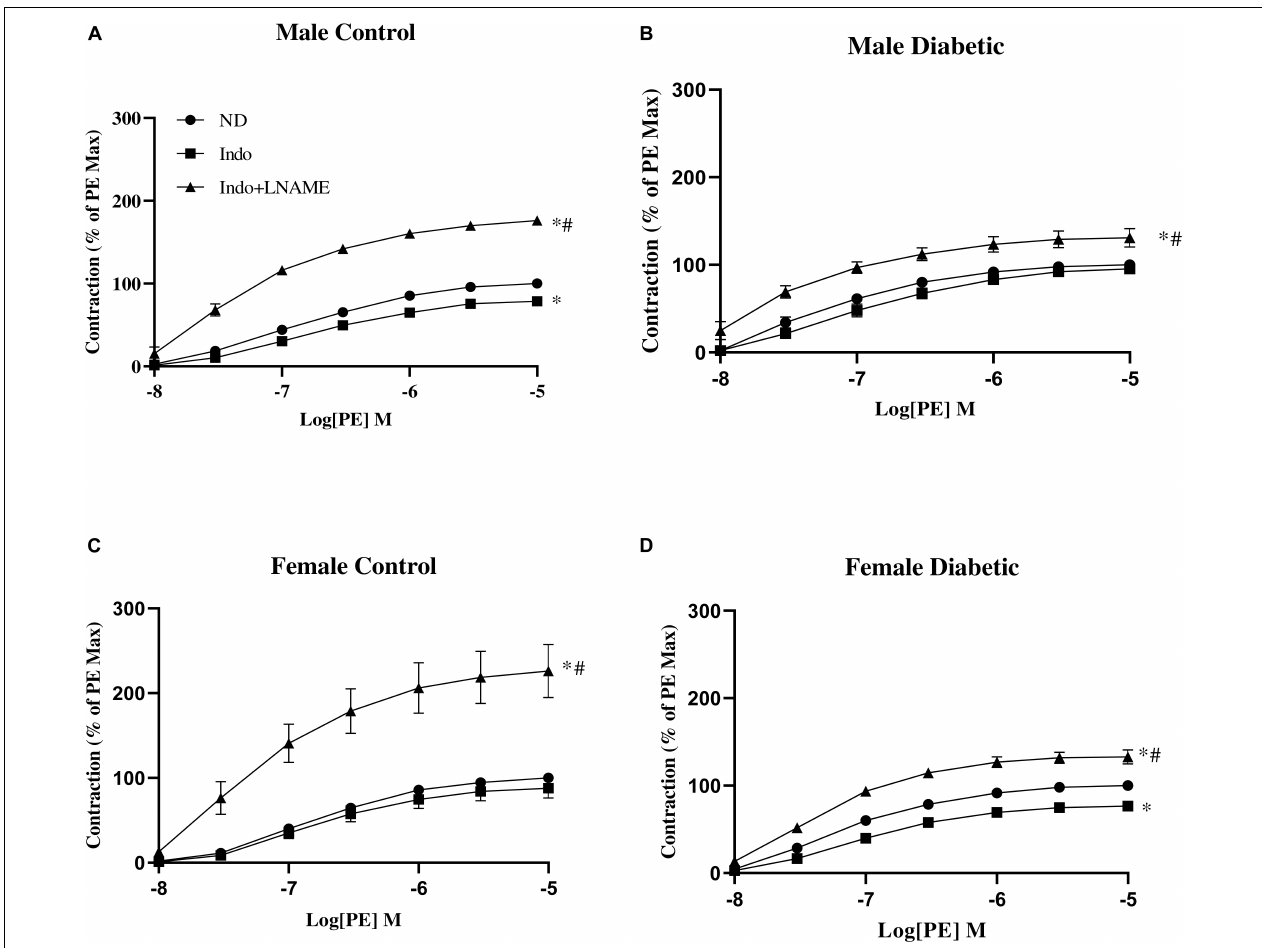
FIGURE 6 | Concentration-response curves to phenylephrine (PE) in intact aortic rings from (A) male control, (B) male diabetic, (C) female control, and (D) female diabetic rats. Contraction to PE was measured in absence of any drug (ND) or in presence of indomethacin (Indo, 10 µ M) followed by addition of N -Nitro-L-arginine methyl ester (Indo + L-NAME, 200 µ M). Results are expressed as a percent of the maximal response to PE (10 µ M) obtained in the absence of any drug. Data are expressed as mean ± SEM, analyzed using two-way ANOVA with repeated measures followed by Tukey’s post hoc test: ∗ p < 0.05 vs. ND; # p < 0.05 vs. Indo, n = 6–8 per